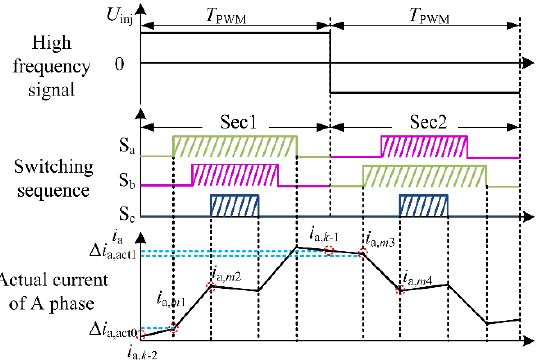
Figure 9. The actual change of phase A current with the proposed method.